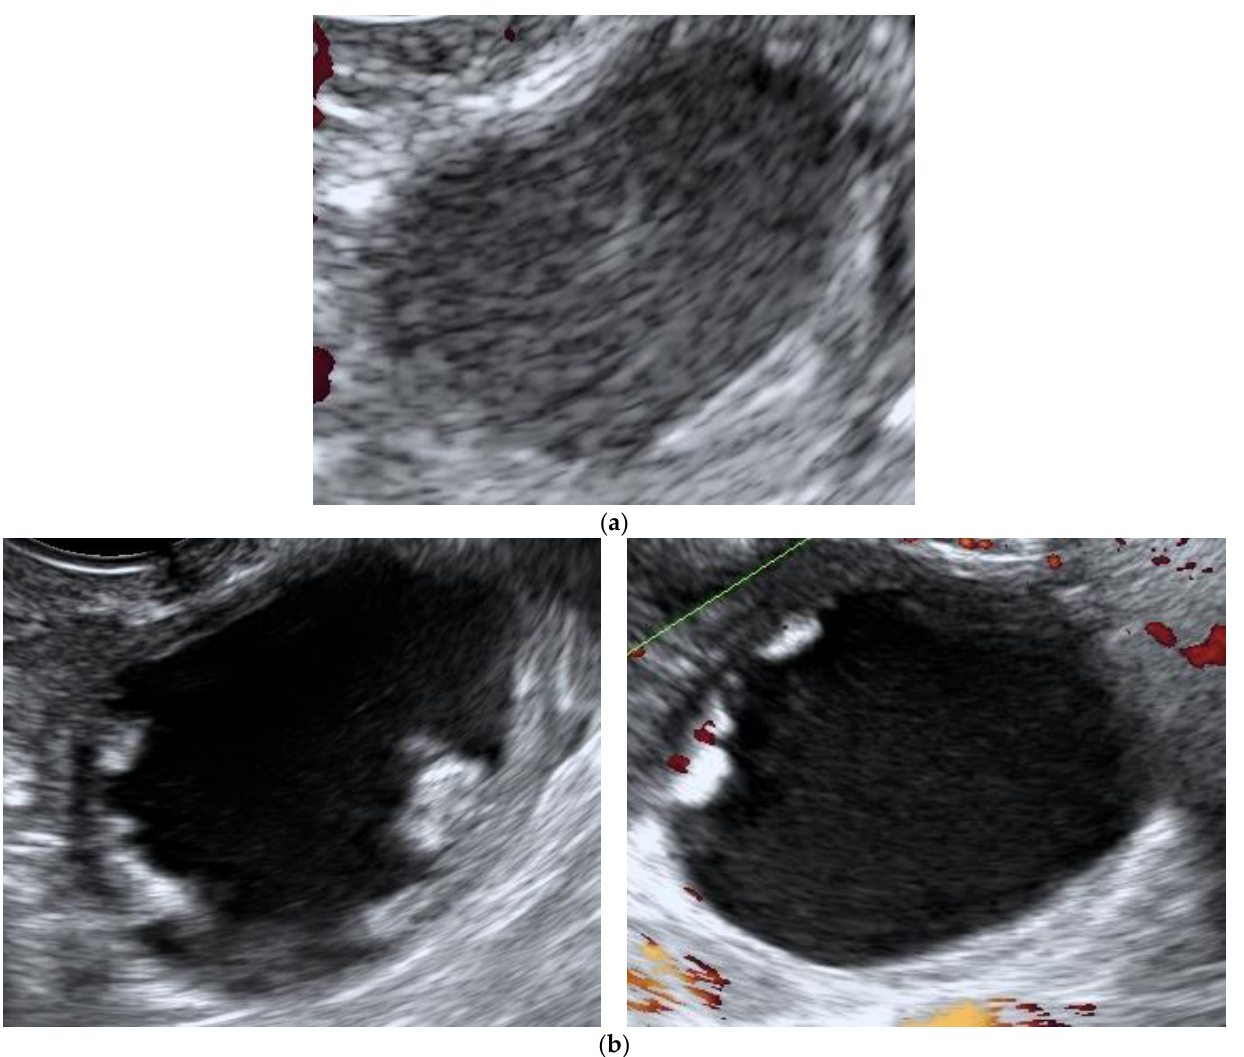
Figure 2. Ultrasound features of borderline ovarian tumor initially classified as a benign lesion. ( a ) Unilocular ovarian formation with “ground glass” content and color score 1 with 35 × 30 × 20 mm, observed in an asymptomatic post-menopausal woman (age: 52 years), classified as a benign by the IOTA ADNEX model and assumed to be a sequel. ( b ) The same lesion with increased sonographic morphological complexity observed at the 3rd evaluation, 9 months after the diagnosis (multilocular — solid tumor with color score 3, CA-125 14.1 U/mL).